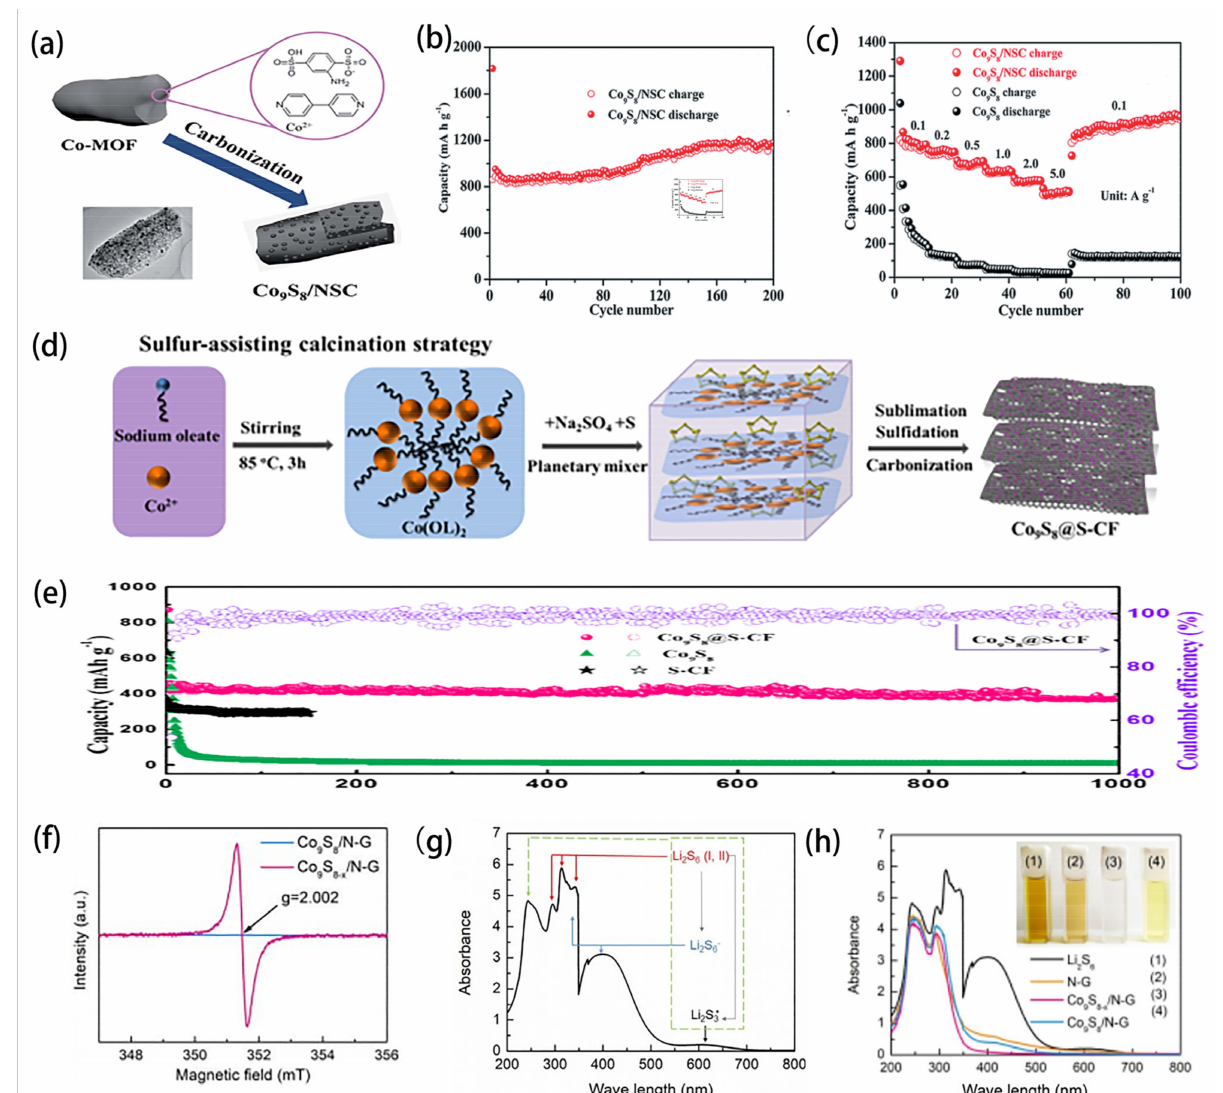
Figure 8. ( a ) Schematic drawing of the formation process to obtain the hybrid composite Co 9 S 8 /NSC. ( b ) the cycling performance at 0.1 A g 1 of Co 9 S 8 /NSC. ( c ) rate capability. Reprinted with